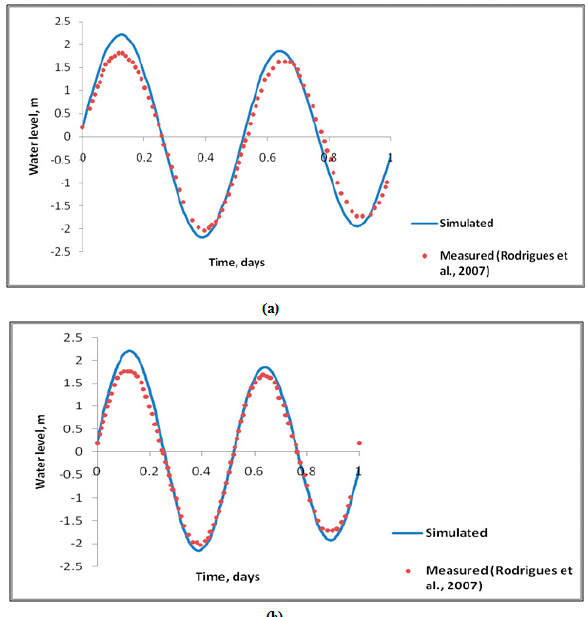
Figure 1. Comparison of current Simulations (continuous lines) and field measured values from Rodrigues et al, 2007 (solid circles) [26] of water level elevation about mean: ( a ) At 15 km; and ( b ) at 19 km from upstream end.